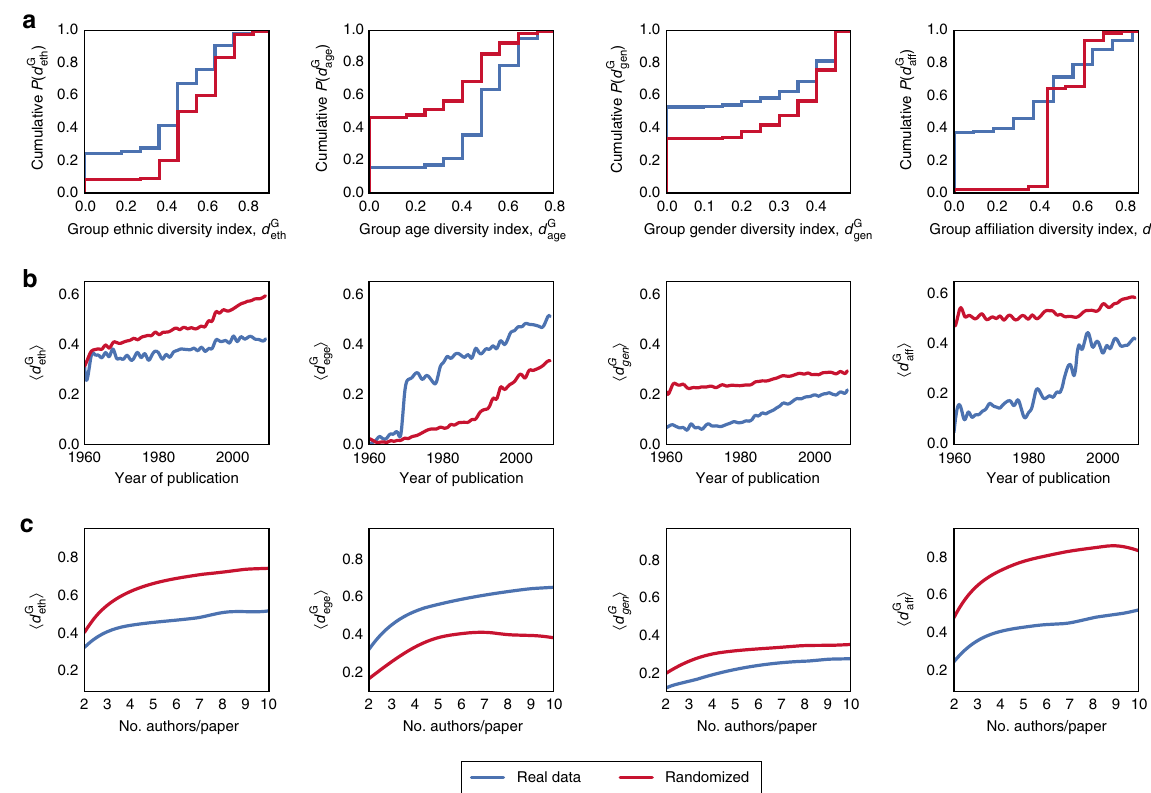
Fig. 1 Exploring homophily in real vs. randomized data. Each column corresponds to a different class of diversity, and each row presents the results of : x 2 f eth ; age ; gen ; aff g in real data is compared against randomized data. a Cumulative distributions of d G a speci fi c set of experiments whereby d G x over time. c Mean diversity h d G for papers with different number of b Change in mean diversity h d G x i x i